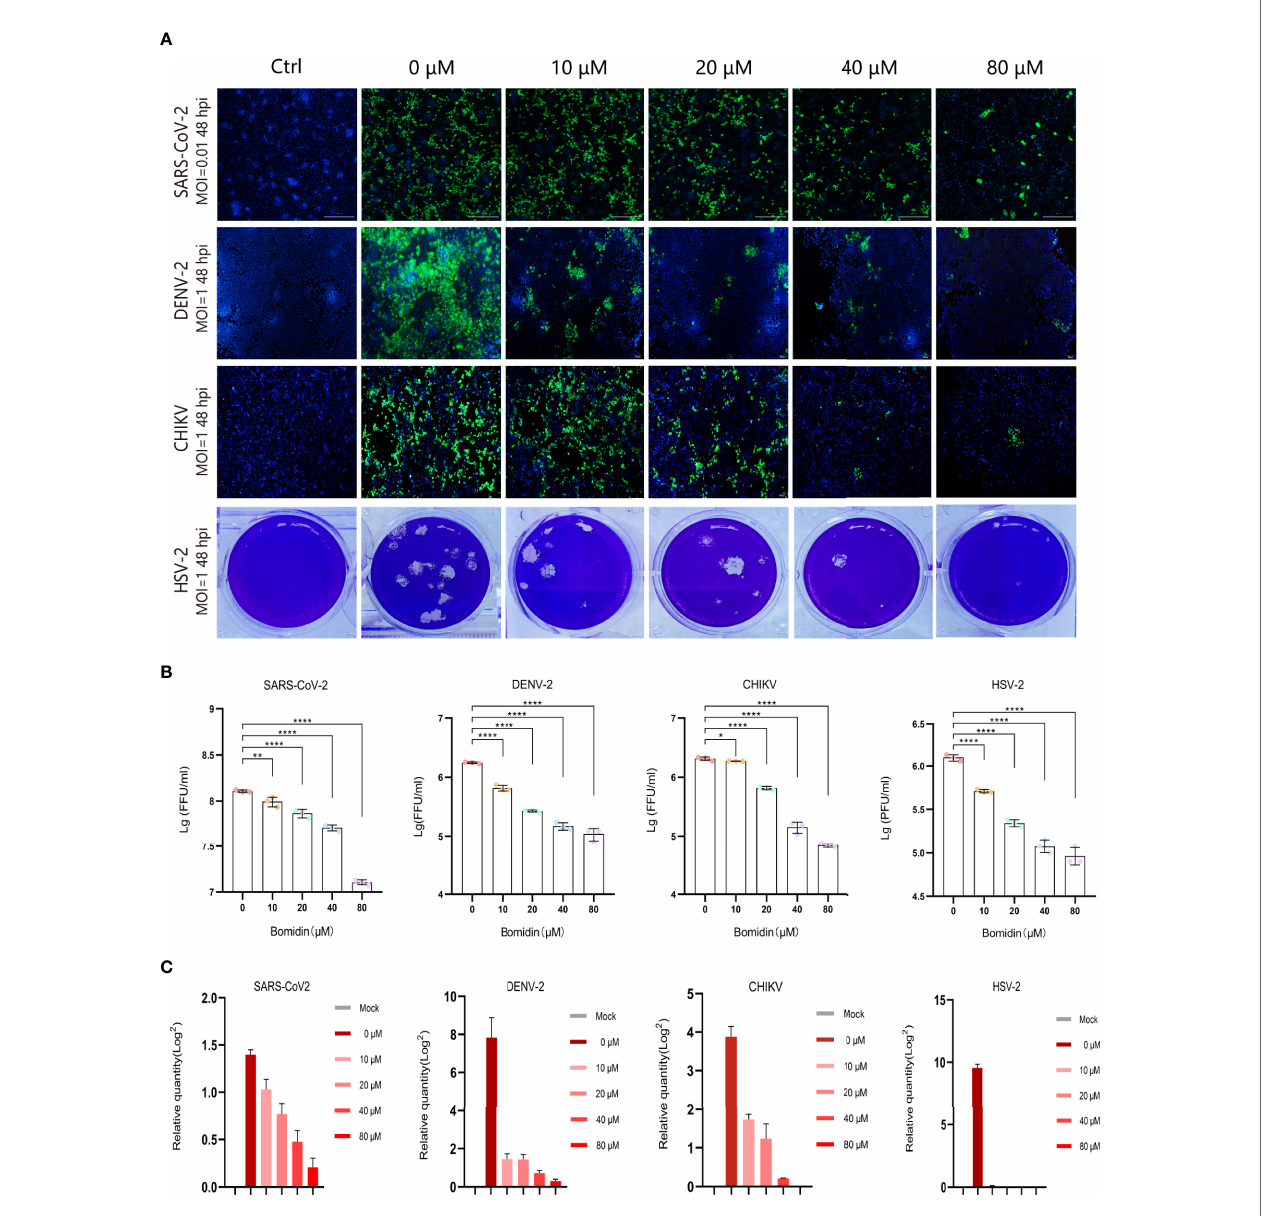
FIGURE 3 | Broad spectrum antiviral activity of bomidin against viral infection in cells. (A) The dose-dependent inhibitory effect of bomidin at different concentrations (0 m M, 10 m M, 20 m M, 40 m M and 80 m M) was determined by an immuno fl uorescence assay (SARS-CoV-2, DENV-2 and CHIKV) and a plaque forming assay (HSV- 2) 48 h postinfection. Cell nuclei were stained with DAPI (blue). The viral proteins are indicated in green. (B) Fluorescence quanti fi cation. (C) Bomidin inhibition of virus RNA formation at different concentrations (0 m M, 10 m M, 20 m M, 40 m M and 80 m M) was determined by quantitative real-time PCR 48 h postinfection, and GAPDH was used as the housekeeping gene for normalization. The data are shown as the means ± S.D.; n = 3 cell cultures per experiment. *p < 0.05; **p < 0.01; ****p <